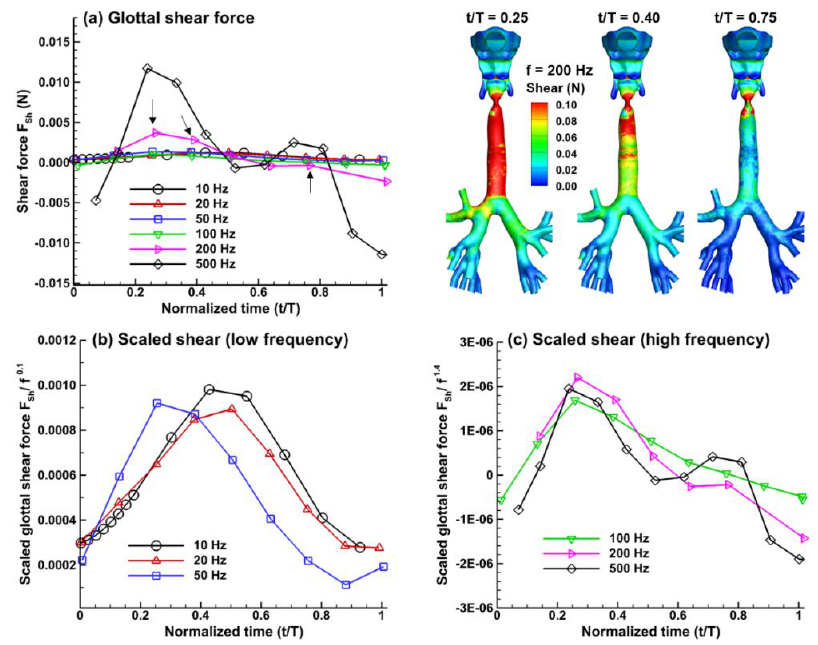
Figure 6. Shear forces acting on the glottal walls: ( a ) the variation in the shear force acting on the glottal walls in one vibration cycle, with the shear force visualized at three instants (arrows) of the 200 Hz case. The shear force, τ does not obey a continuous relationship with the glottal vibration frequency, ( b ) with a very weak τ dependence on f when f ≤ 50 Hz ( f 0 0.1 ) and ( c ) a much higher dependence on f 0 when f ≥ 100 Hz ( f 0 01.4 ).